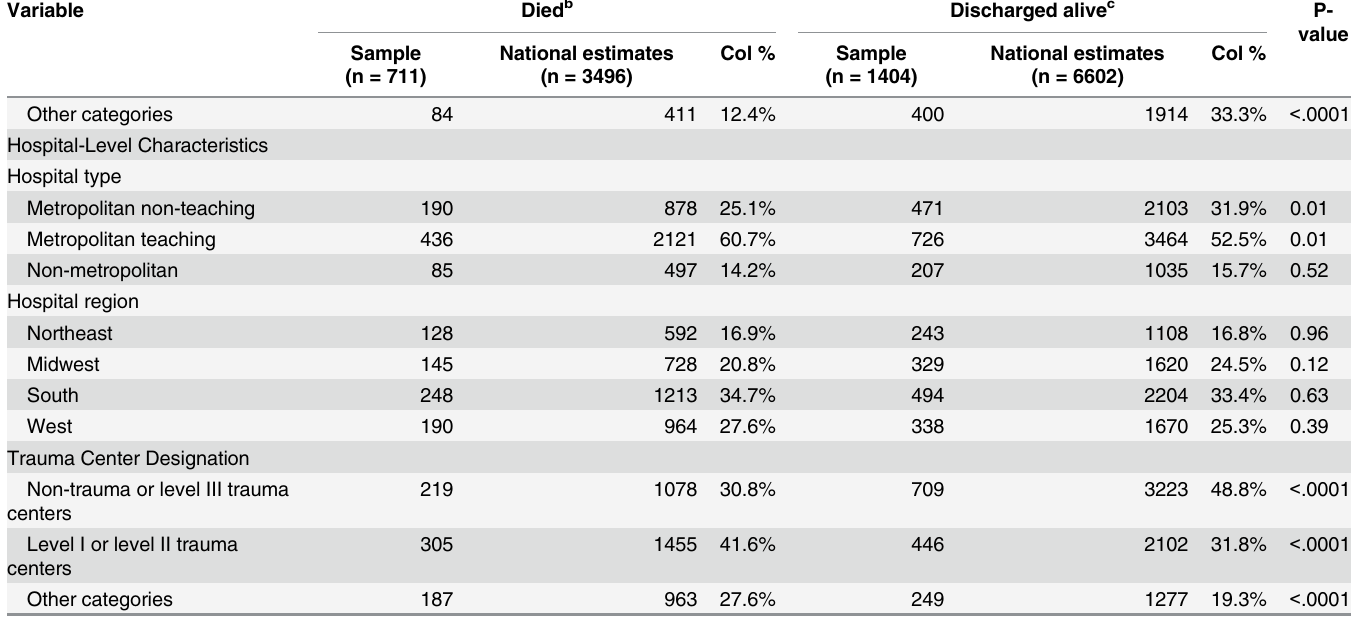
Abbreviations: NEDS, Nationwide Emergency Department Sample.